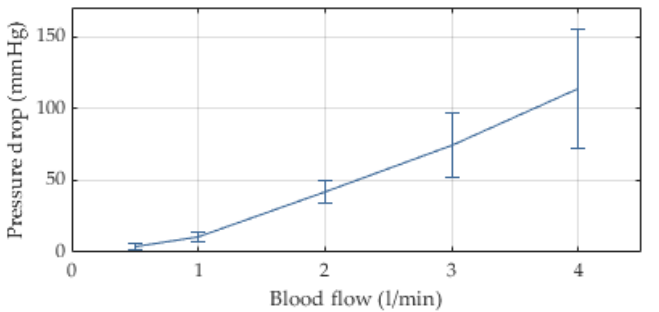
threefold normalized index of hemolysis (NIH) of the novel device compared to a reference device (Figure 9).